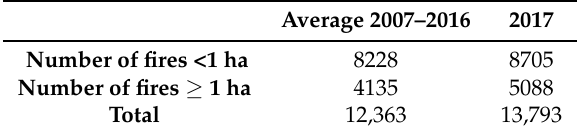
Table 1. Number of fires in 2017 compared with the 10 year average [5].